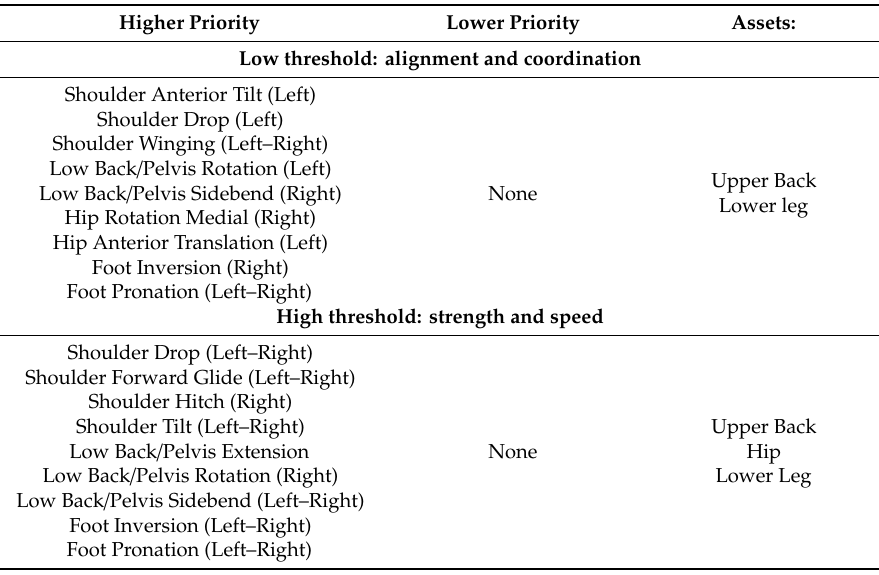
Table A1. The Foundation Matrix report detailing the site direction and threshold of movement control impairments found